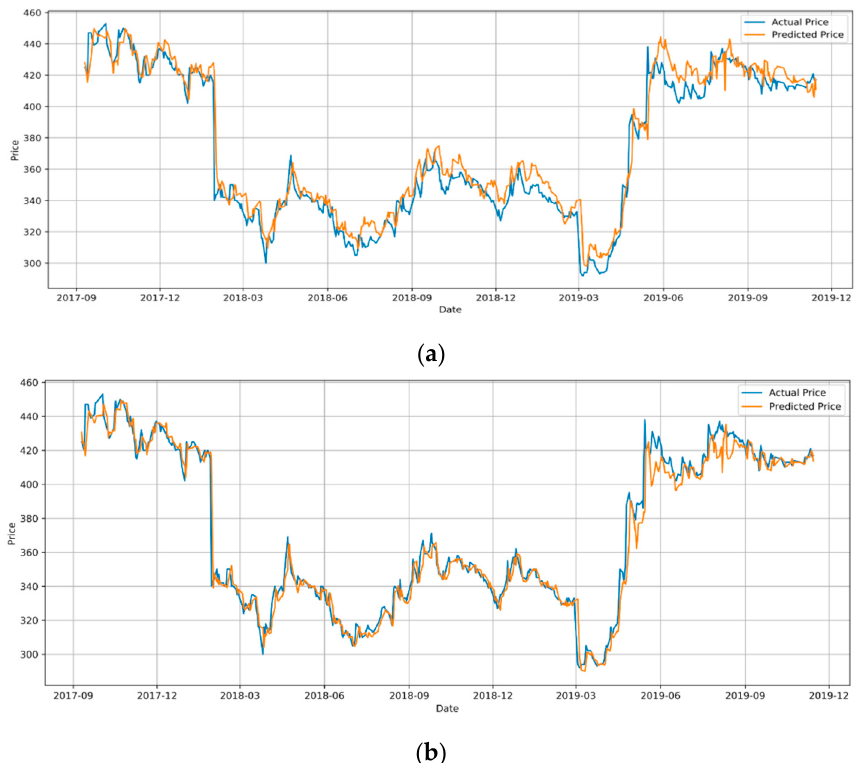
Figure 7. The actual and predicted price of ADBL from 12/09/2017 to 14/11/2019: ( a ) LSTM with News; ( b ) GRU with News.